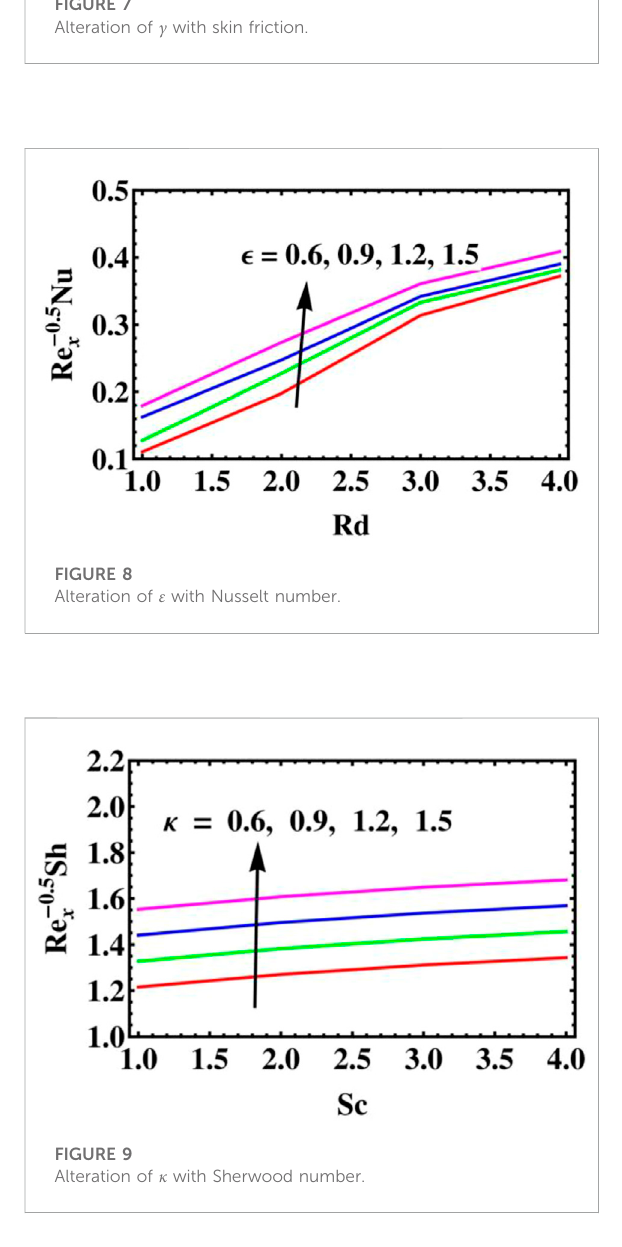
FIGURE 7 Alteration of γ with skin friction.